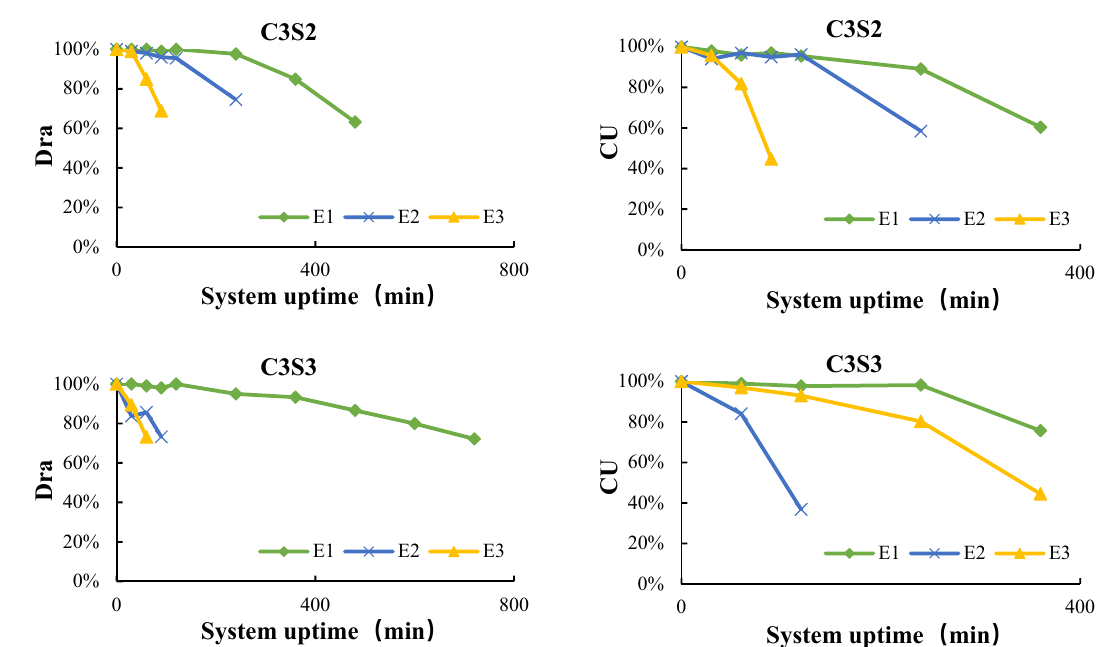
Figure 3. Flow and evenness of emitters during the system operation period.